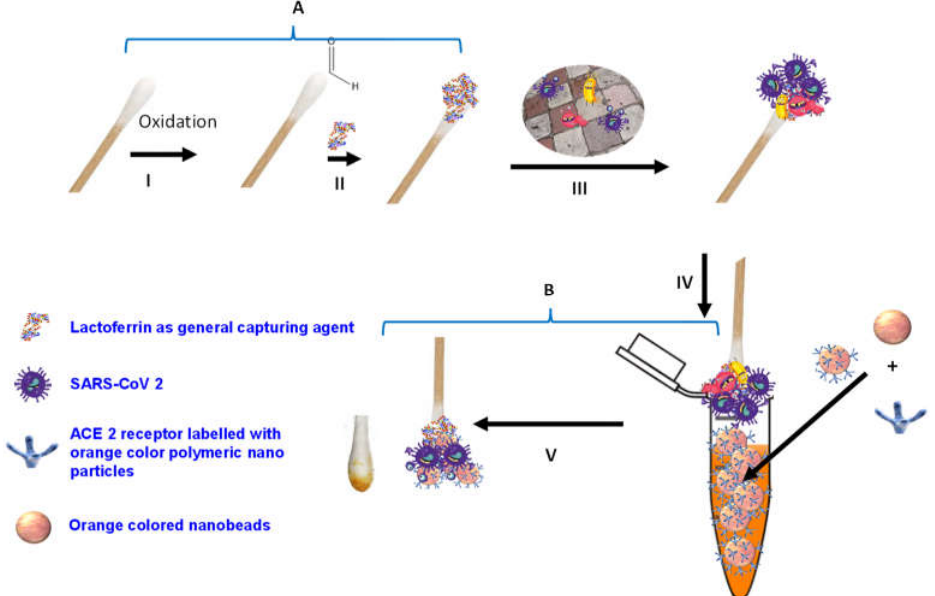
Figure 1. Schematic diagram of SARS-CoV-2 colorimetric sensing Q-tips. ( A ) Preparation of cotton swab-lactoferrin sensor. ( I ) Oxidation activation of the Q-tip cotton swab; (II) immobilization of lactoferrin capturing agent on cotton swab surface; ( III ) capturing of SARS-CoV-2. ( B ) Colorimetric detection assay ( IV ) of SARS-CoV-2 spike protein sandwiched between lactoferrin immobilized over cotton swab surface and ACE2 receptor decorated with the orange polymeric nanoparticle; ( V ) SARS-CoV-2 colorimetric detection.